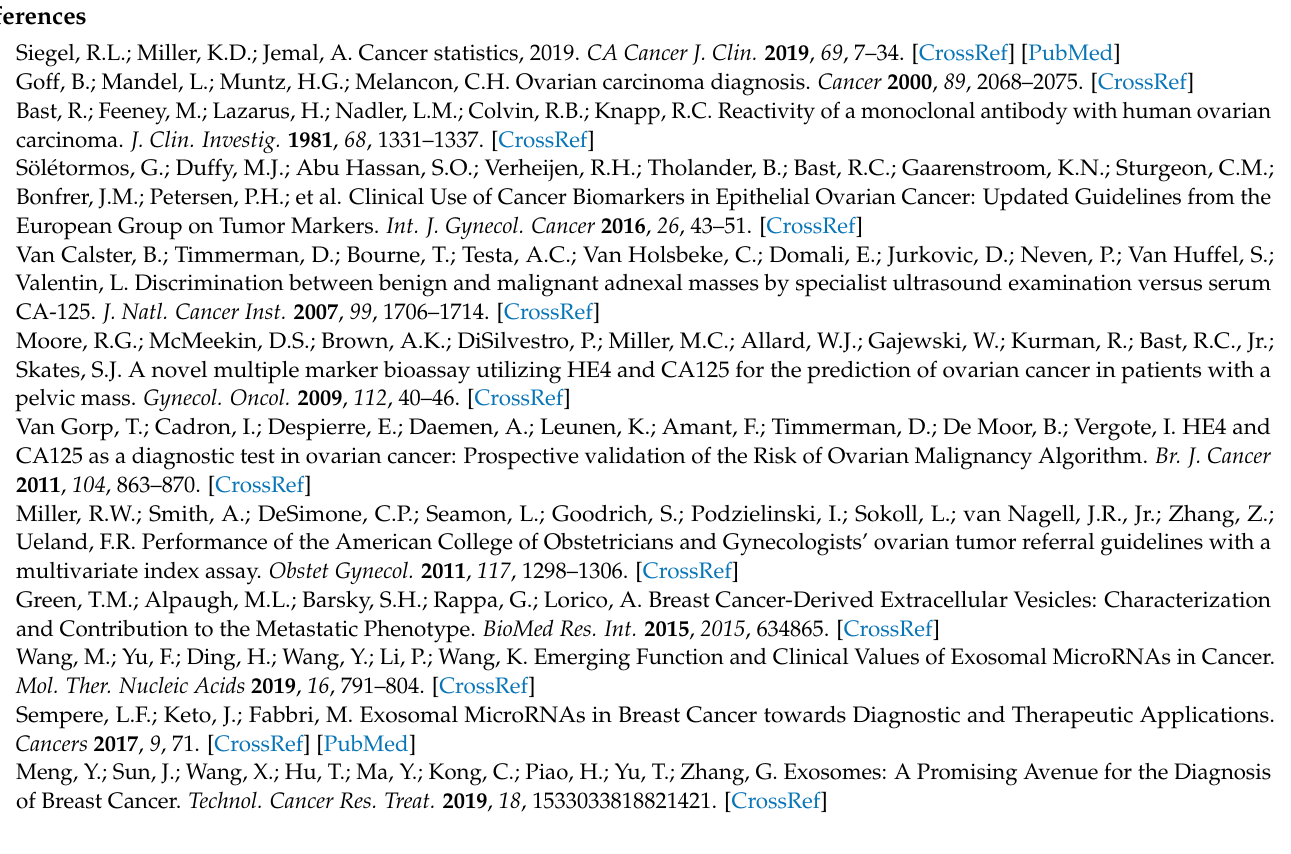
combination (C). Figure S2: SOCS4 Western blotting full image. Figure S3: The dot plot data for